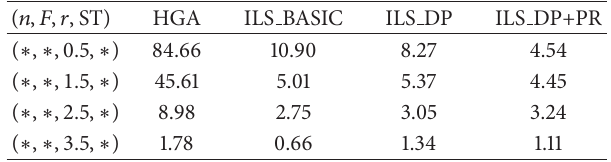
Table 7: Average RDIs (%) for instances grouped by due date ranges ( 𝑟 ).